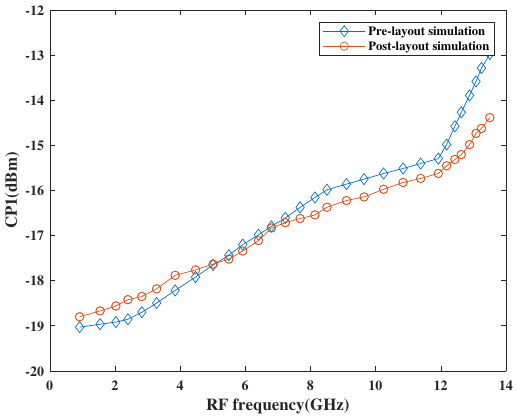
Figure 16. Variation of CP1 with RF frequency.